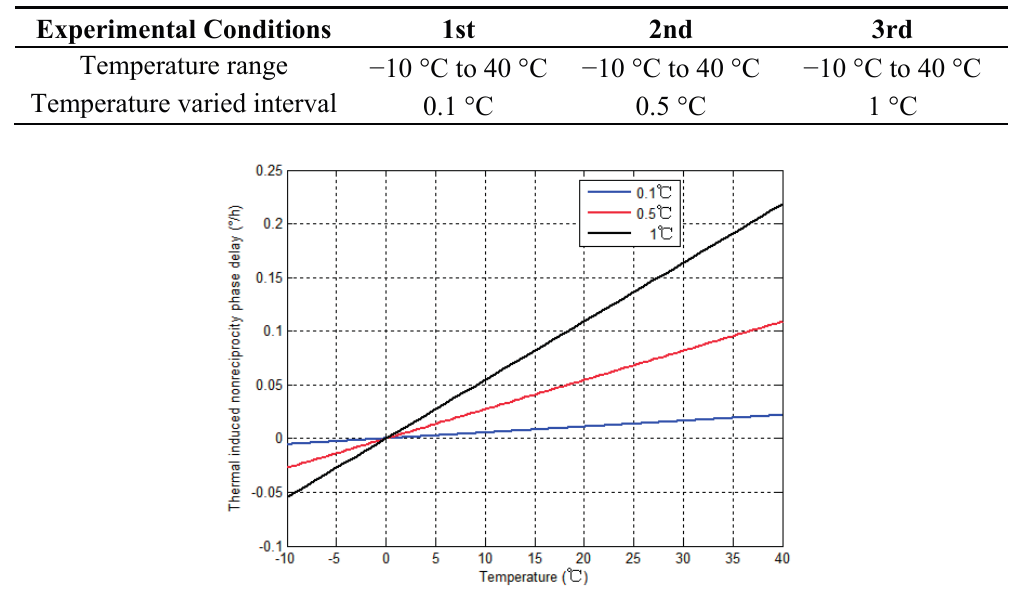
Figure 3. Thermally induced nonreciprocity phase delay in simulation